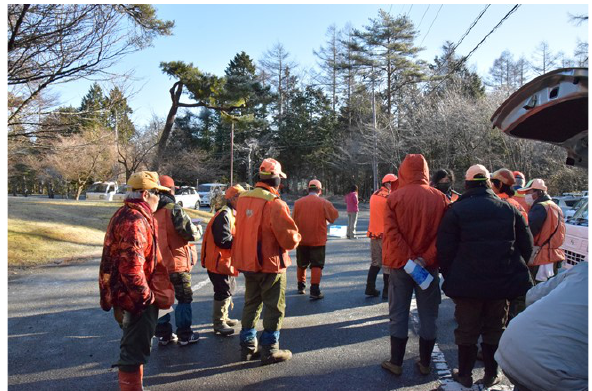
Figure 9 . Beaters and shooters who were handed over a map of sika deer presence.